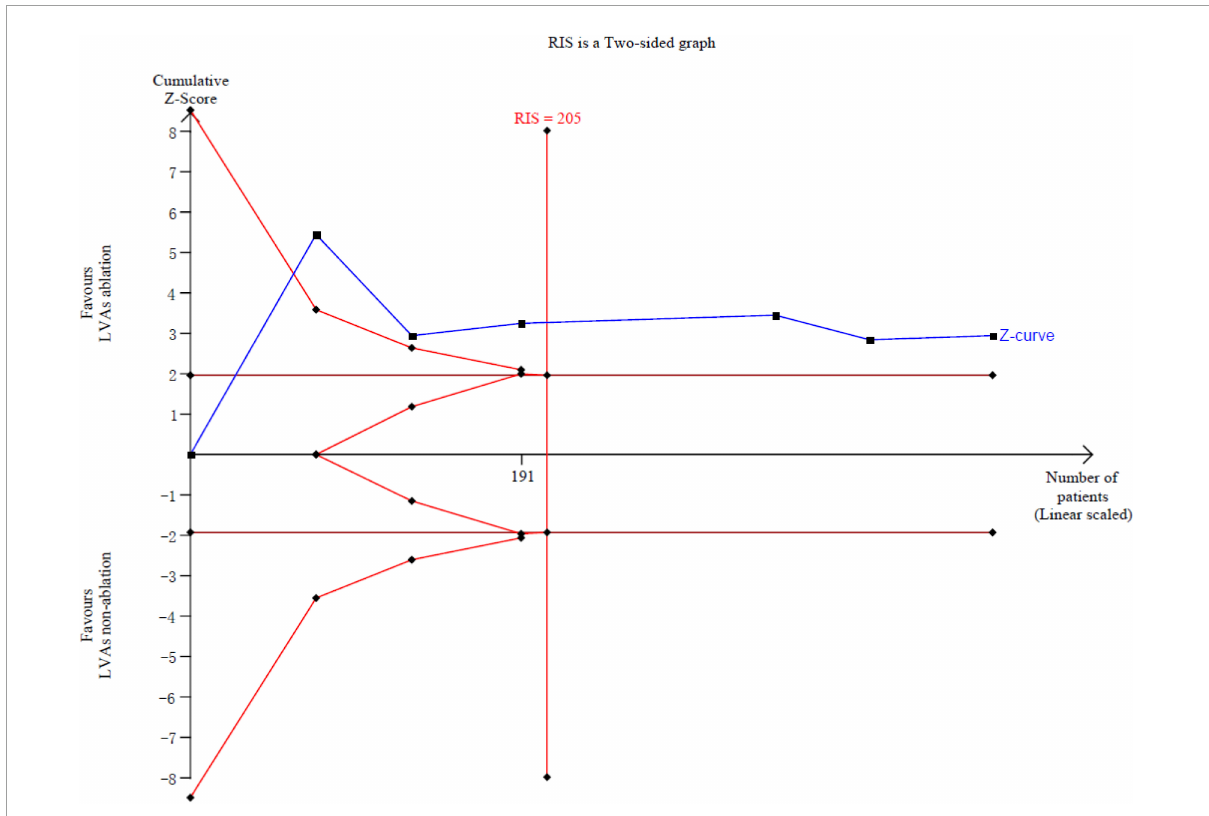
FIGURE6 Trial sequential analysis of the LVAs